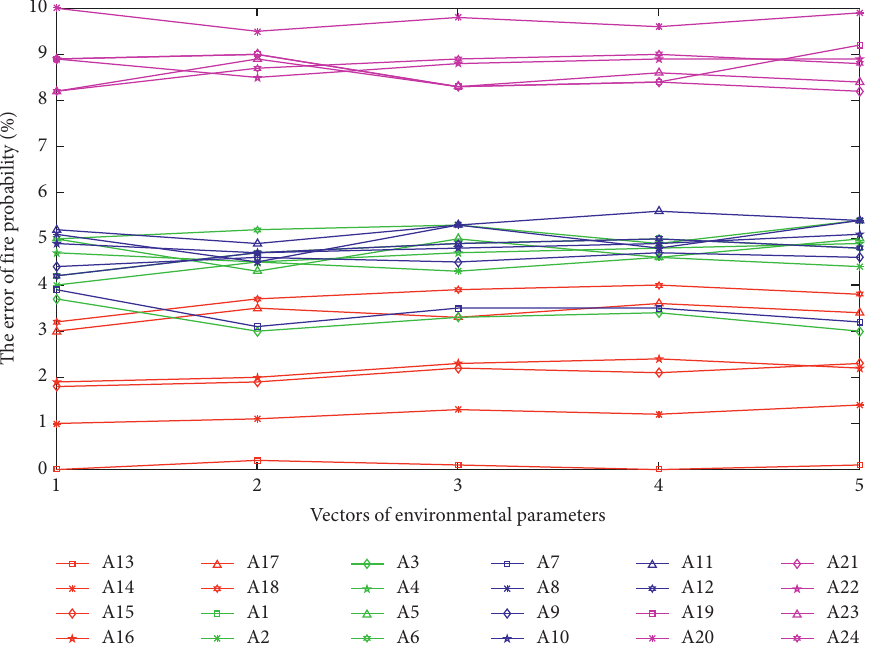
Figure 3: The error curve of fire probability.